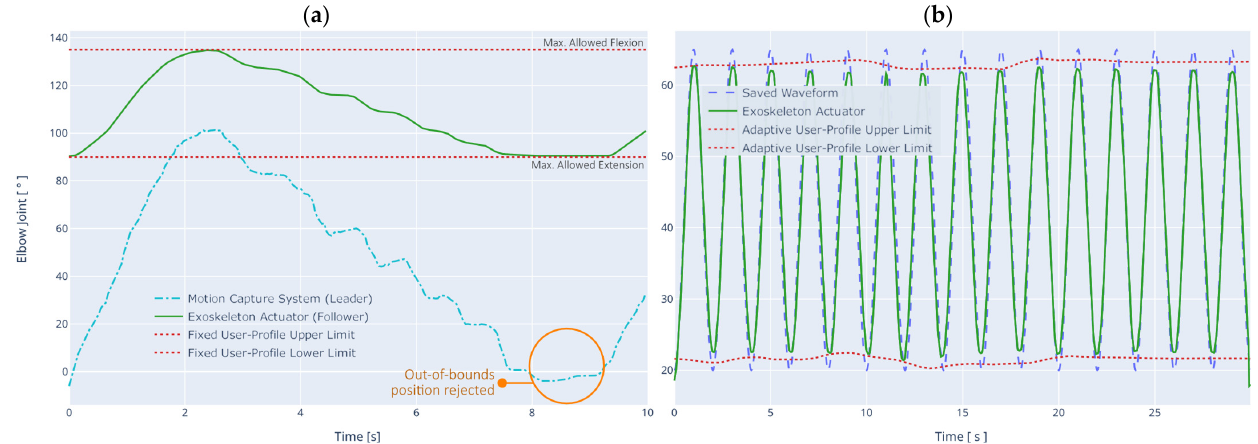
Figure 14. Main safety system test using ( a ) the Leader-Follower Mode with fixed user-profile limits, and ( b ) the Autonomous Mode with adaptive user-profile limits based on the fatigue detectors.